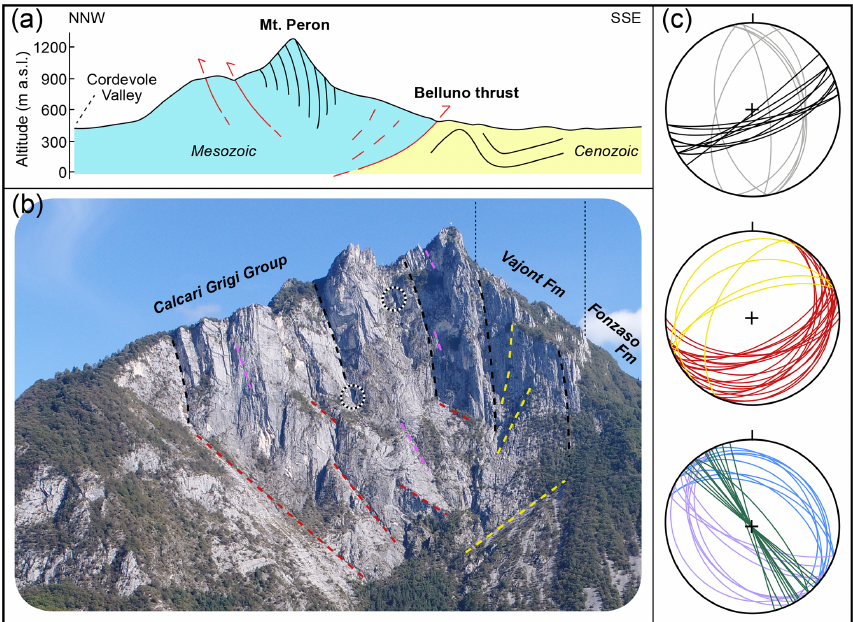
Figure 2. Structural scheme of the Mt. Peron release scarp. (a) Schematic geological cross section. (b) Photograph with major structural elements and larger karst caves (black-and-white circles) highlighted. (c) Lower-hemisphere stereographic projection of principal structural elements. Colours in (b) and (c) correspond to the following: bedding (black), N–S reactivated Jurassic fault-related planes (grey), basal trenches and other high-angle fractures connected to the Belluno thrust (yellow) and backthrust (red), fractures related to the NNW–SSE fault system (light blue), their conjugates (pink), and high-angle fractures with the same orientation